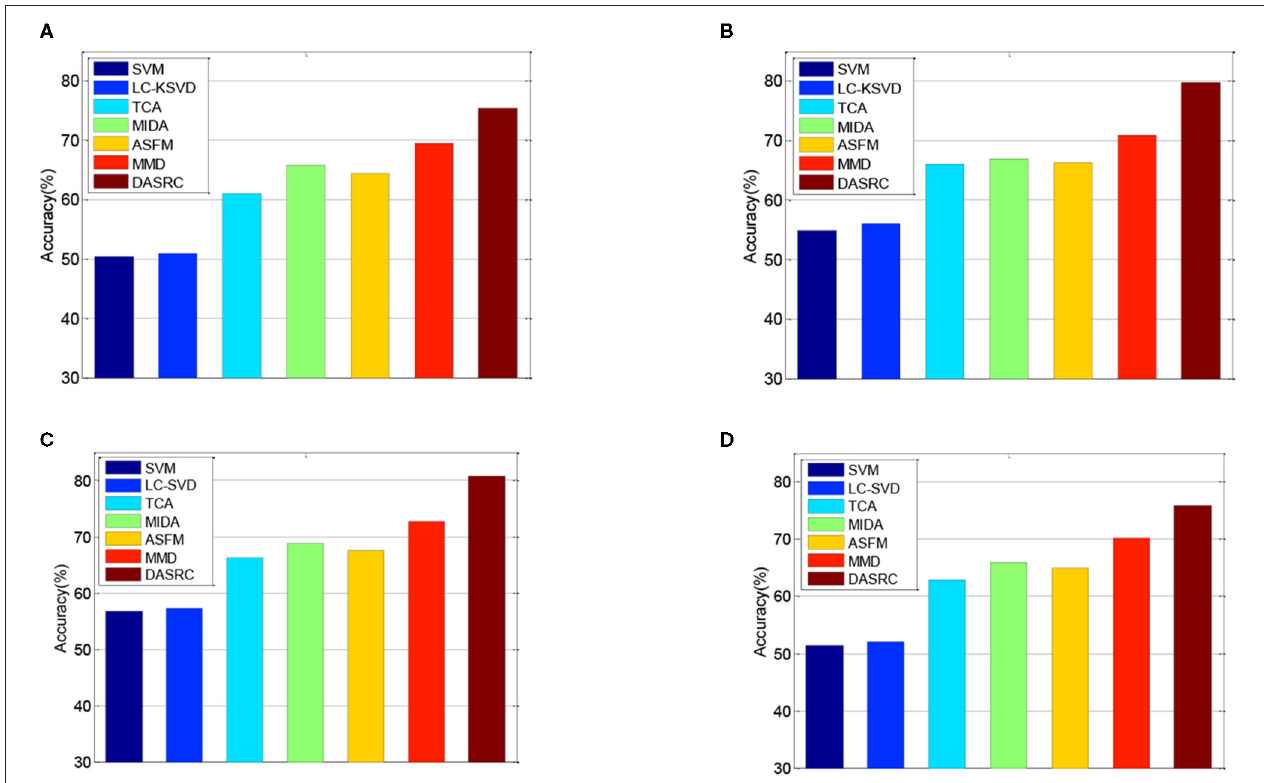
FIGURE 3 | Cross-subject accuracy on SEED dataset with different features, (A) PSD, (B) FD, (C) DE, (D)